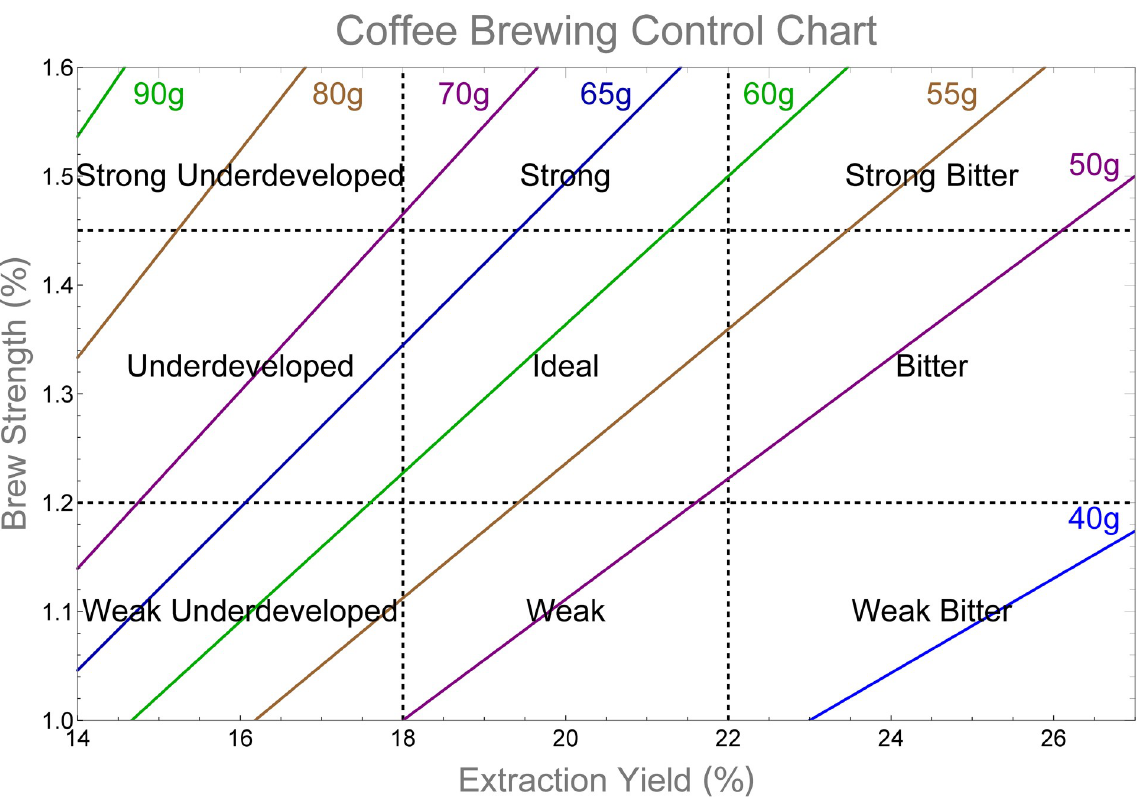
Fig 1. Coffee brewing control chart. Coffee brewing control chart example for drip filter coffee. The coffee quantities marked are for use with 1 kg of water.